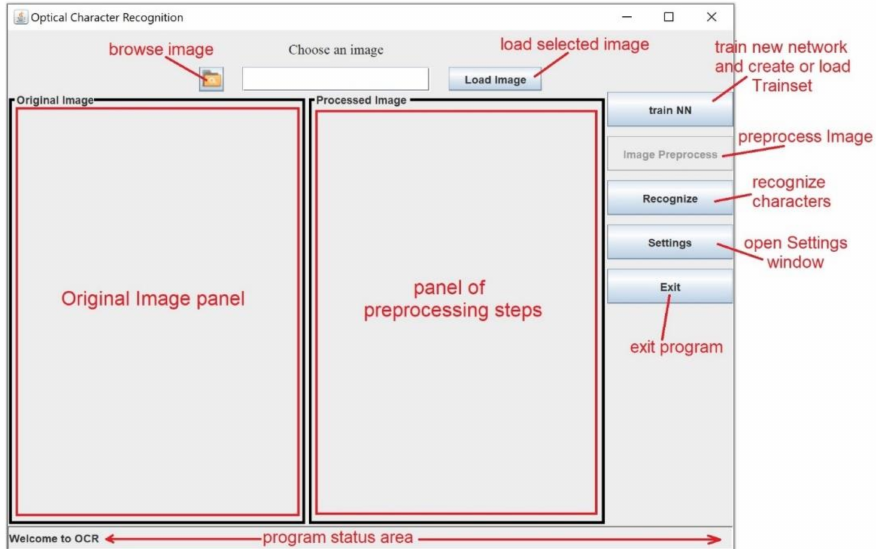
Figure 14. Main interface window of the application.